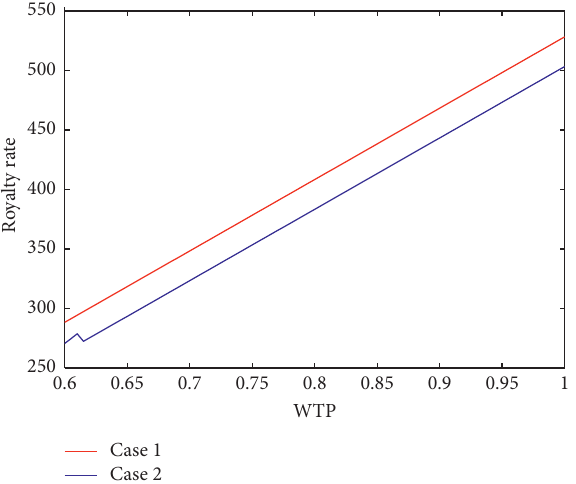
Figure 10: Royalty rate vs. WTP.